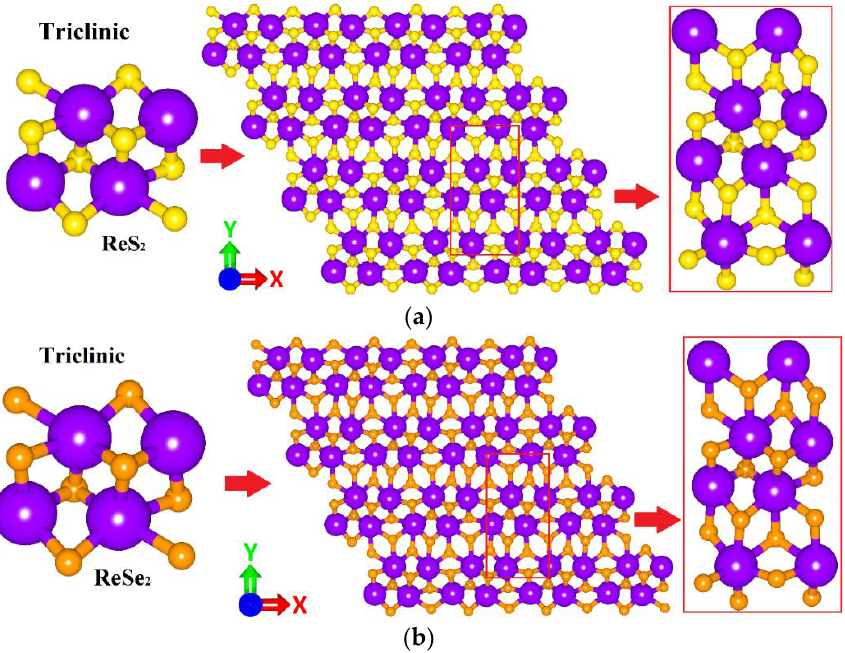
Figure 1. Method for obtaining rectangular supercells of ReS 2 ( a ) and ReSe 2 ( b ) 2D structures. (Sulfur atoms are marked in yellow. Selenium atoms are marked in orange.)